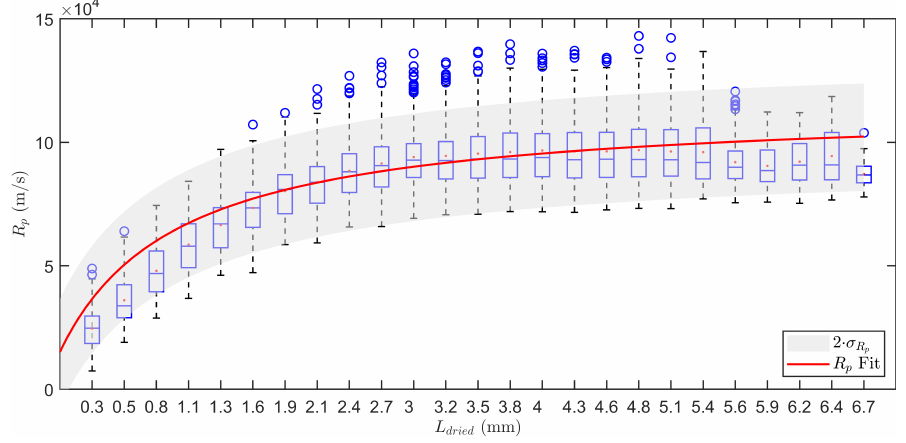
Figure 3. Boxplot representation of the dry layer resistance R p in function of the dry layer thickness L dried . Data obtained during six individual measurements. The box represents the 25th up to the 75th percentile. The whiskers extend to the most extreme data points. Outliers are shown individually by the blue circles. Fit of the R p regression in red with an uncertainty band of 2 σ in